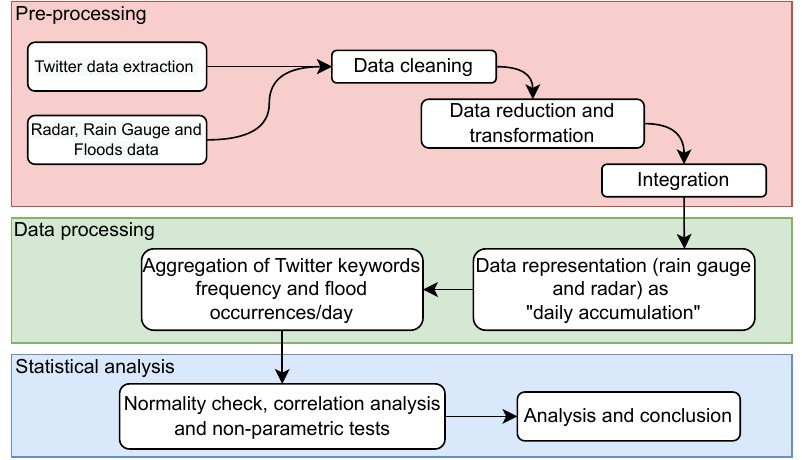
Figure 2. The flowchart illustrates all the treatment and processing steps undertaken for the analyzed data. The data were processed and analyzed using